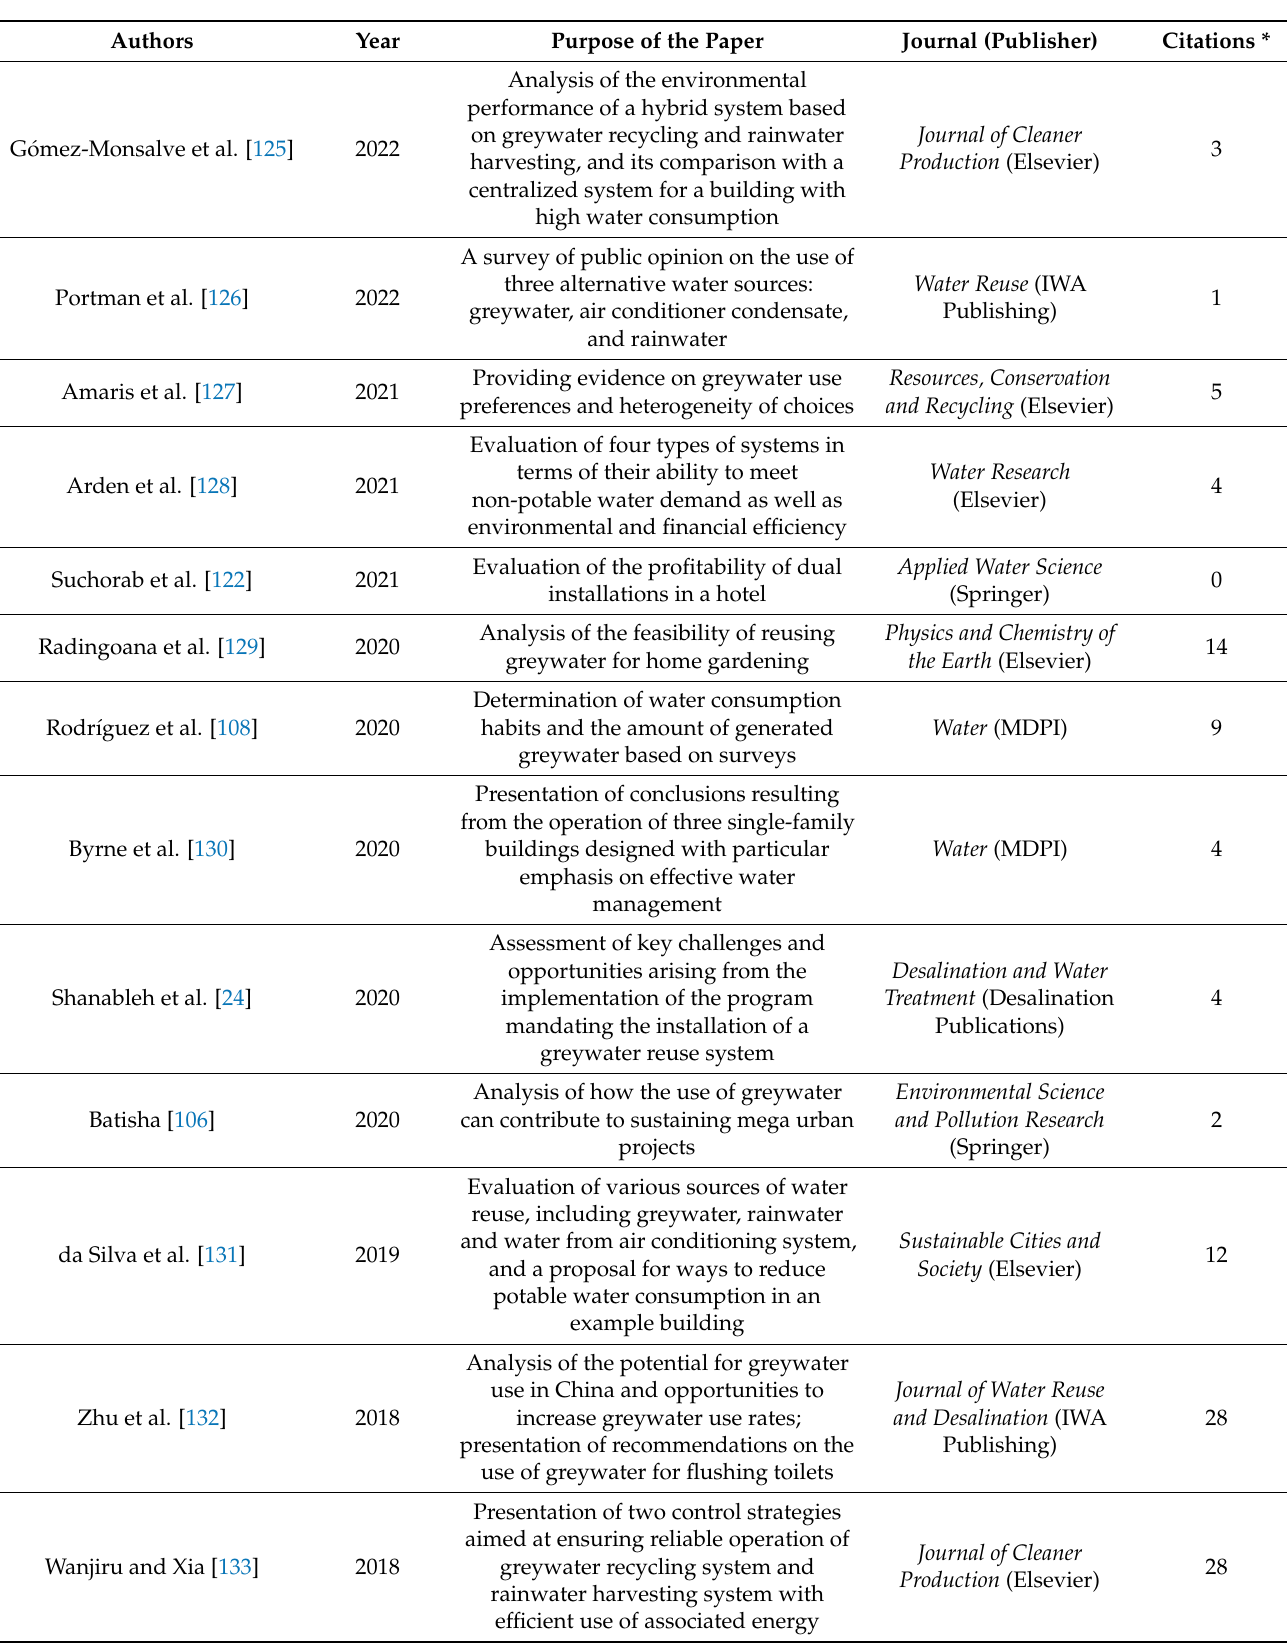
Table 9. Selected research papers from the last five years in greywater recycling